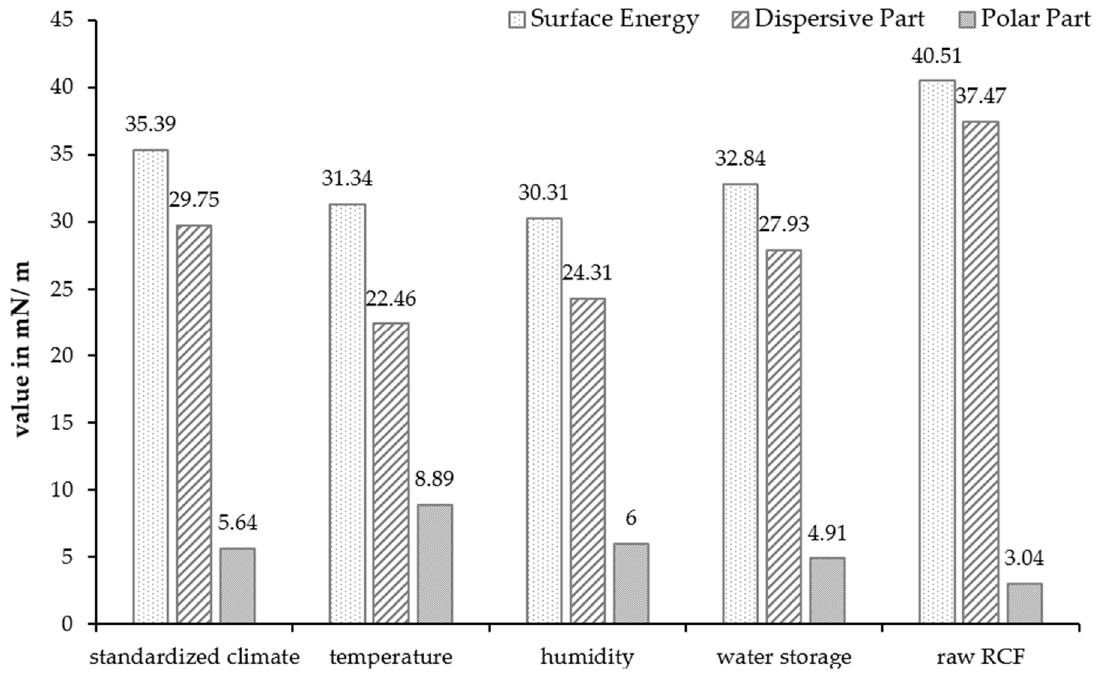
Figure 7. Results of the contact angle measurements of the accelerated-aged and non-reinforced PA5.10 in comparison with the surface energy of raw RCFs [43]. PA5.10 in comparison with the surface energy of raw RCFs [43].